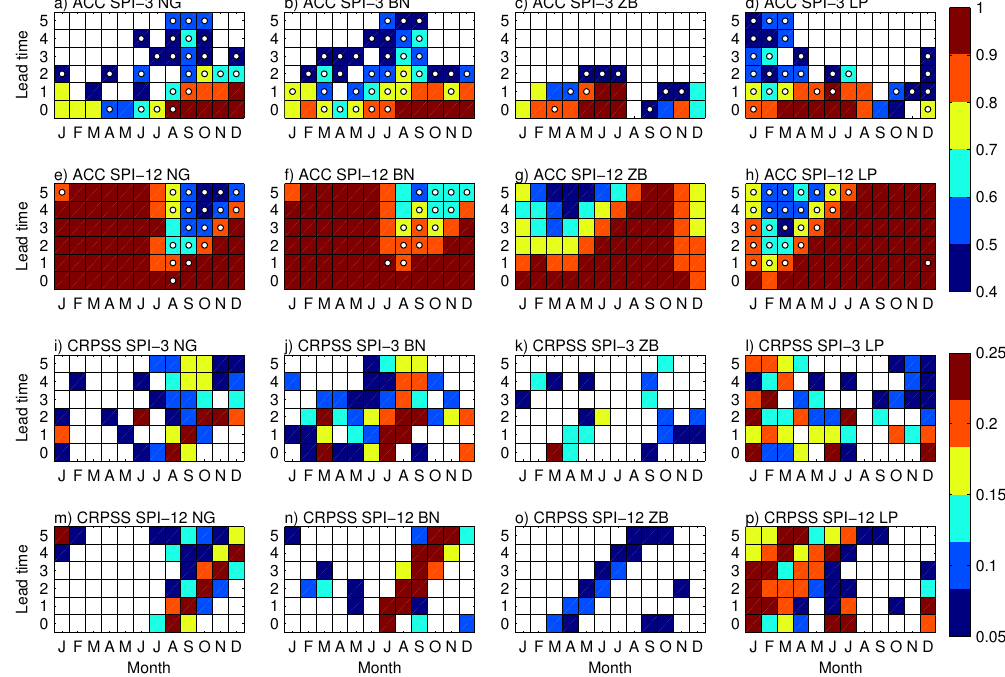
Fig. 7. Anomaly correlation coefficient (ACC) of the seasonal forecasts of SPI-3 (a–d) and SPI-12 (e–h) , and continuous rank probability skill score (CRPSS) of SPI-3 (i–l) and SPI-12 (m–p) . In the colour matrix, the horizontal axis represents the verification month and the vertical axis the lead time (months). In the ACC S4 forecasts are compared with GPCP, and the white circles indicate that the S4 ACC > CLM ACC by at least 0.05. In the CRPSS panels, S4 CRPS is benchmarked against the CPRS of